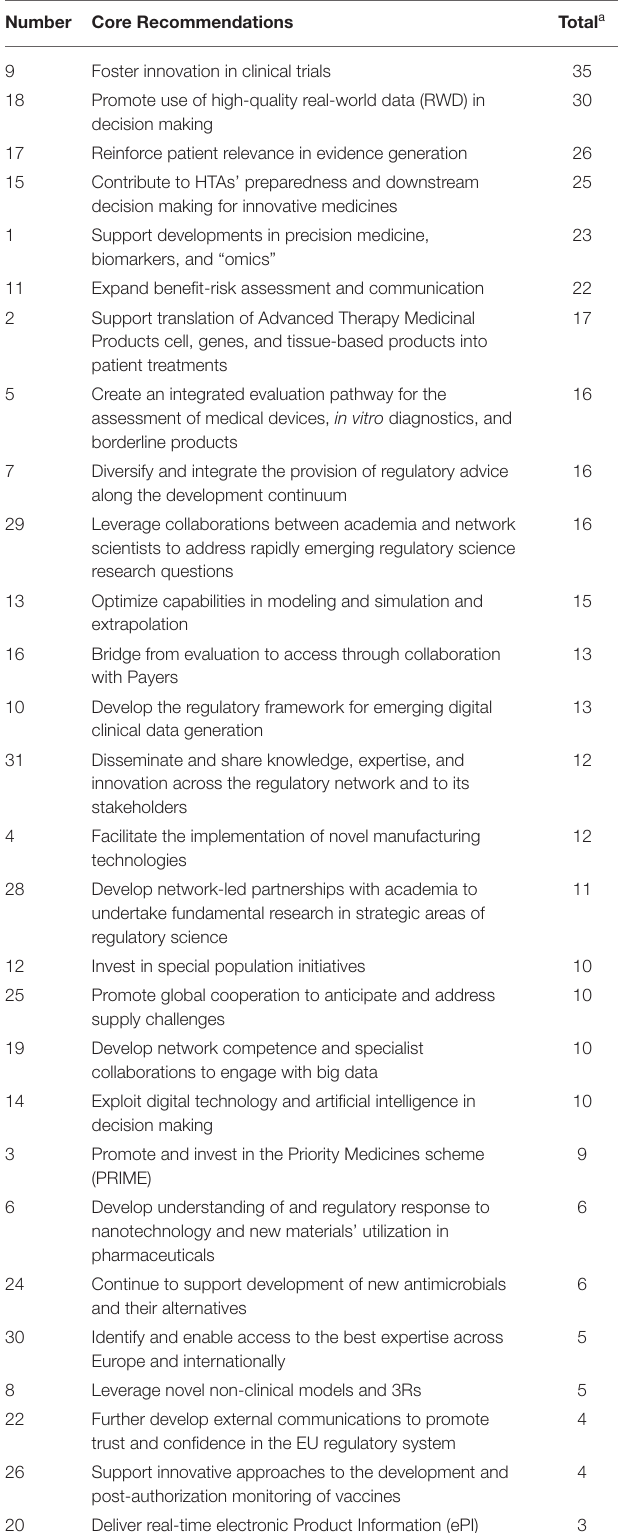
TABLE 2 | Aggregate ranking of Core Recommendations (question 5,